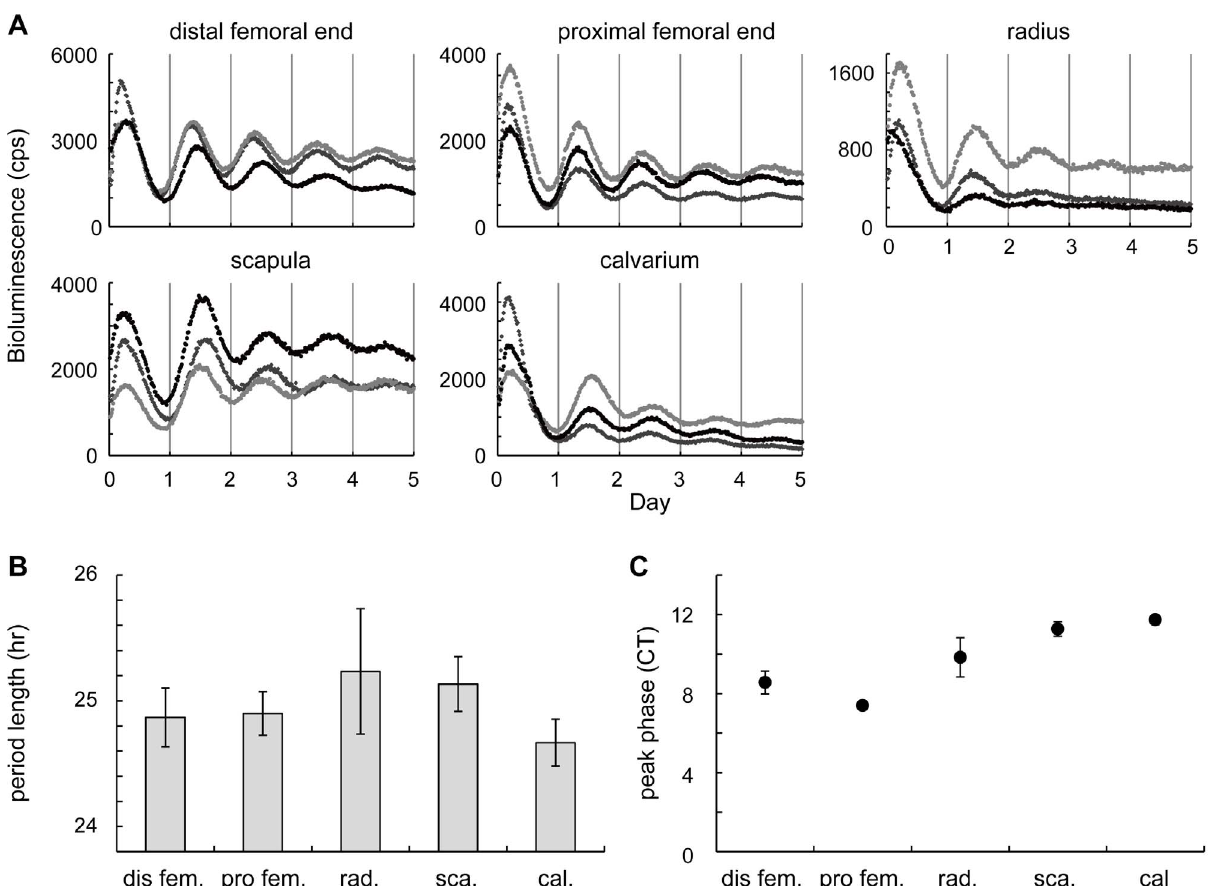
Figure 2. Circadian clocks in different bone tissues. ( A ) Bioluminescence circadian rhythms obtained from the distal femoral end, proximal femoral end, radius, scapula, and calvarium. Color dots (light gray, gray and black) indicate traces from three independent samples. ( B–C ) The quantitative analysis of circadian bioluminescence rhythms. The period length ( B ) and bioluminescence peak phase ( C ) are shown (mean 6 SEM, n=3). For peak phase calculation, CT0 was set as a start time of the measurement. CT: Circadian time; dis fem: distal femoral end; pro fem: proximal femoral end; rad: radius; sca: scapula; cal: calvarium.